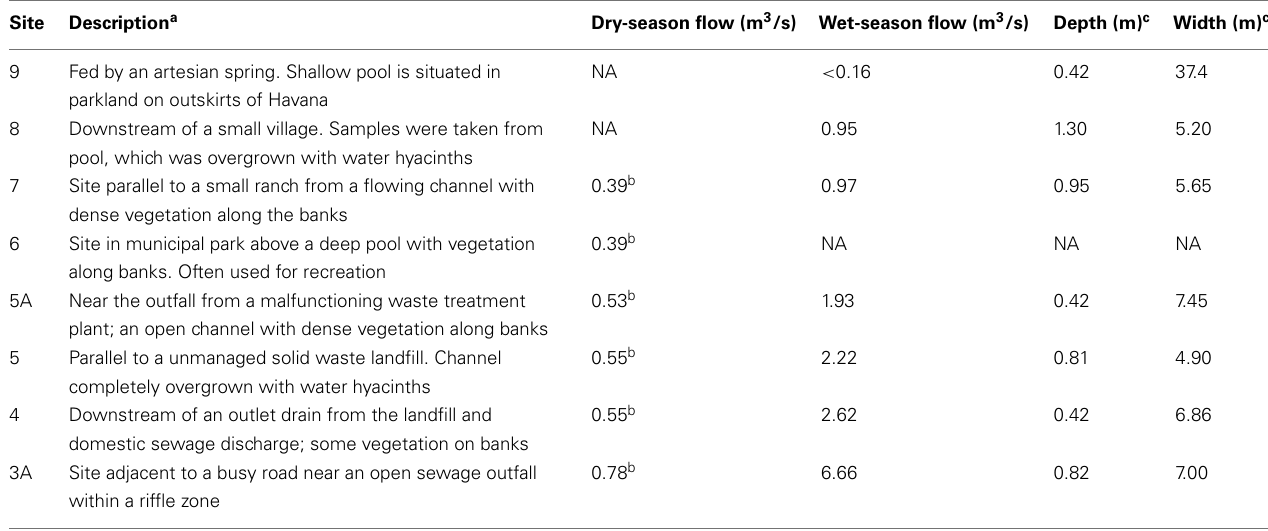
Table 1 | Description of sampling stations along theAlmendares River,